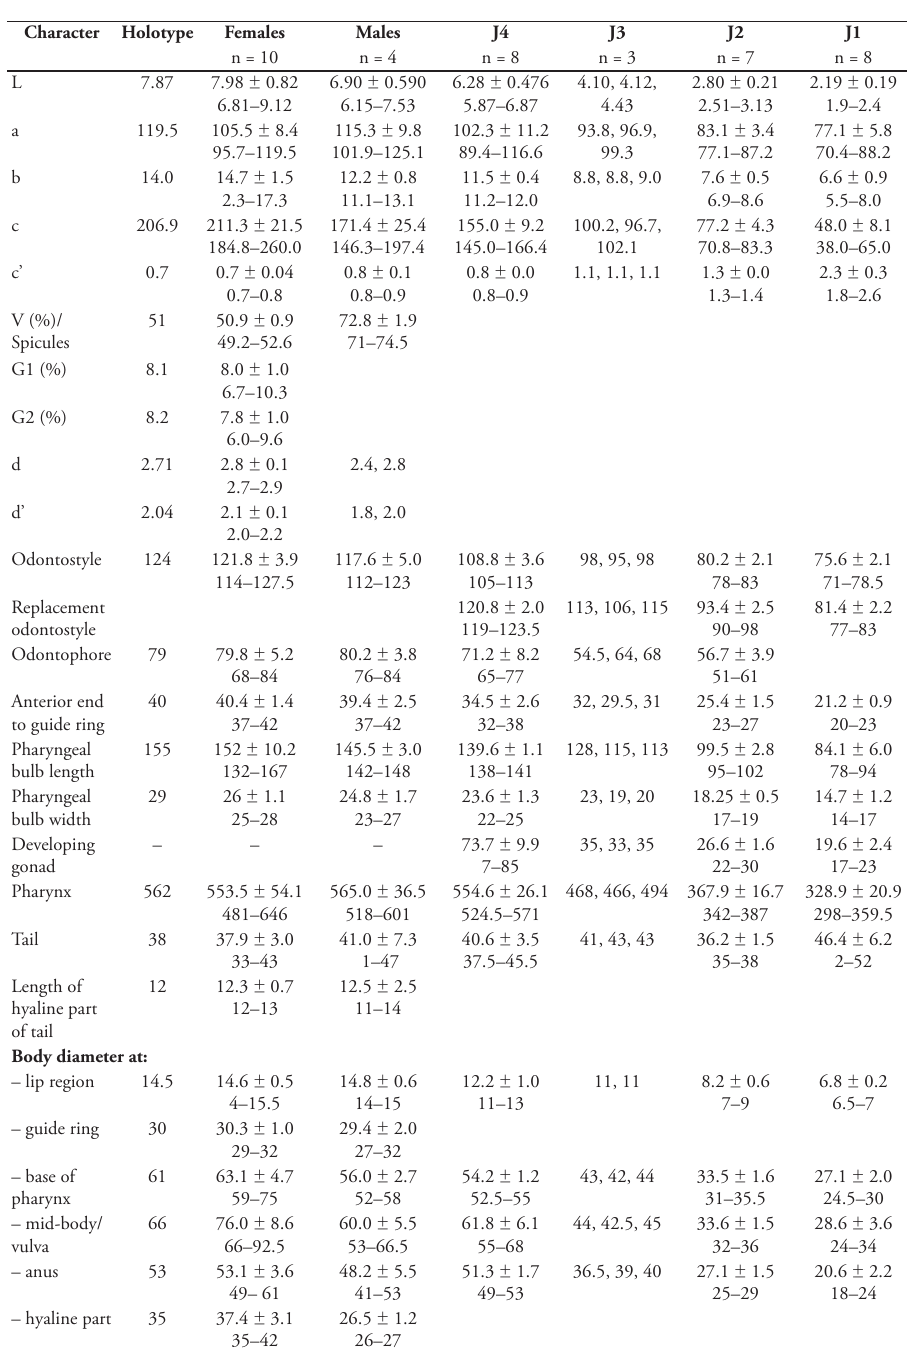
Table 1. Measurements of adults and juveniles of Longidorus polyae sp. n. (mean ± standard deviation, with range). All measurements in micrometers except body length